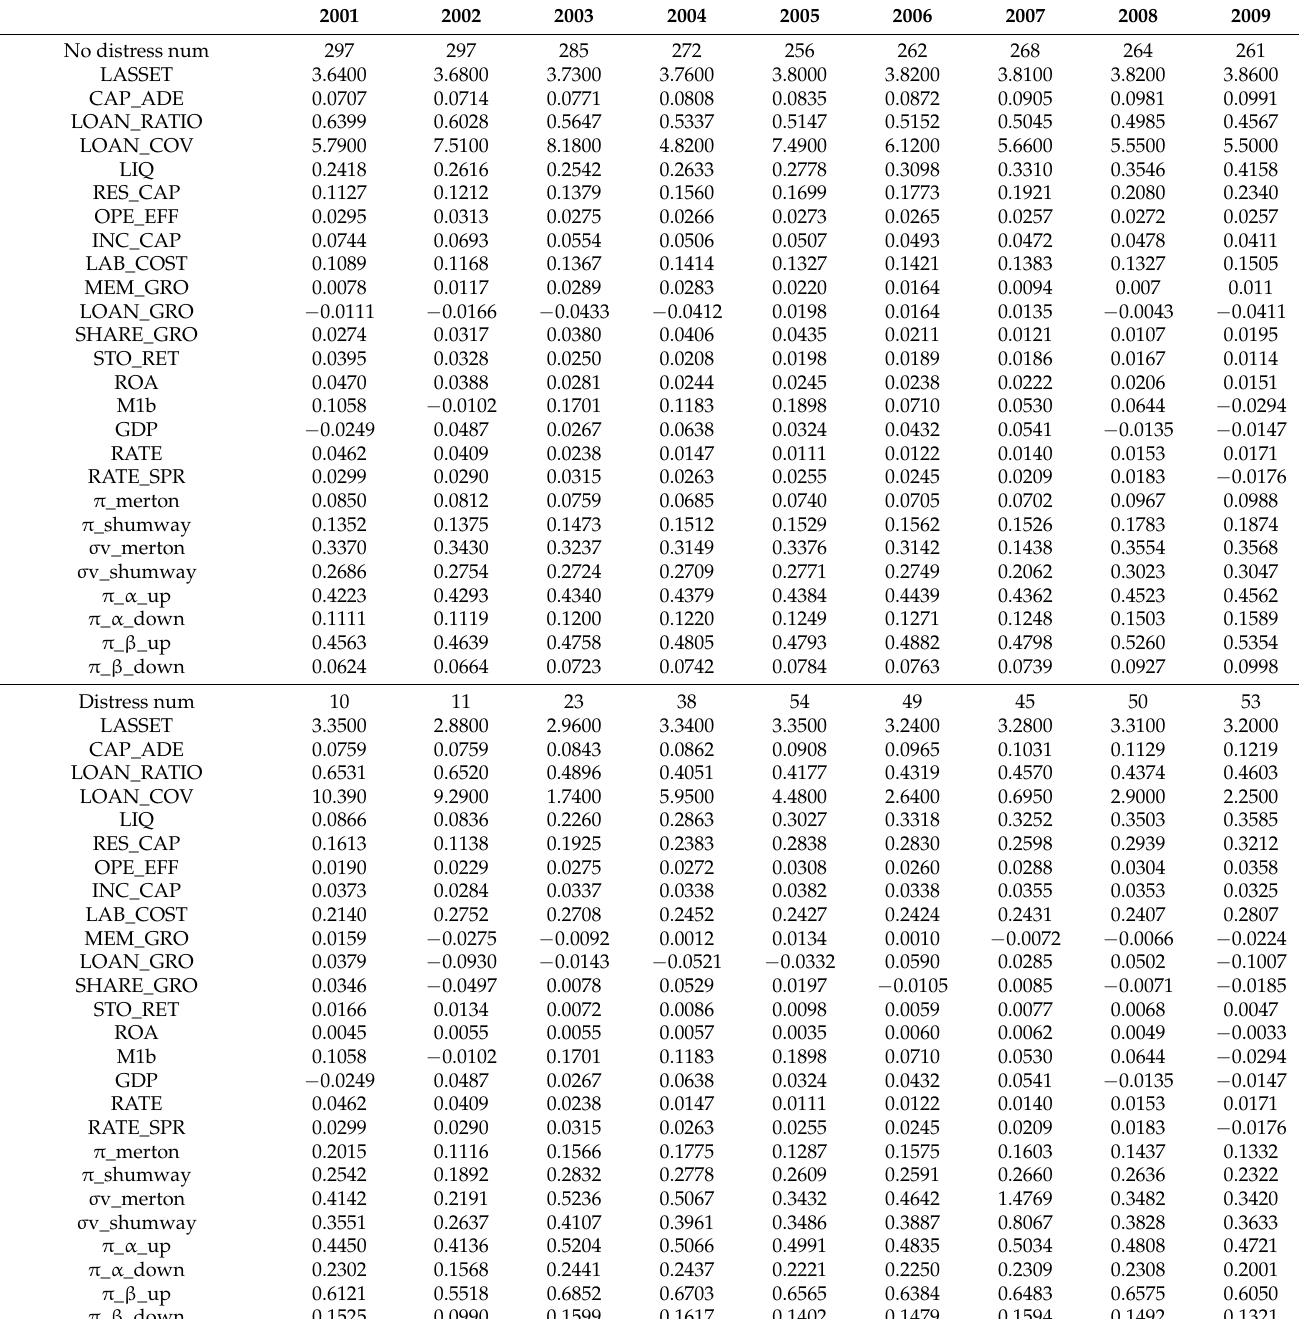
Table 5. Mean values of time-varying covariates by observation: Sample credit unions that are distressed and are not distressed during the subsequent one-year period from